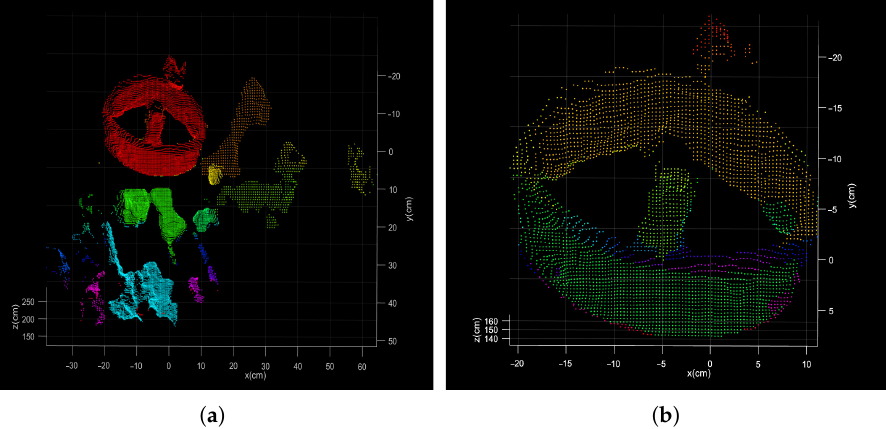
Figure 11. Direct segmentation result of point cloud. ( a ) the result after the planar background segmentation; ( b ) the result after the clustering